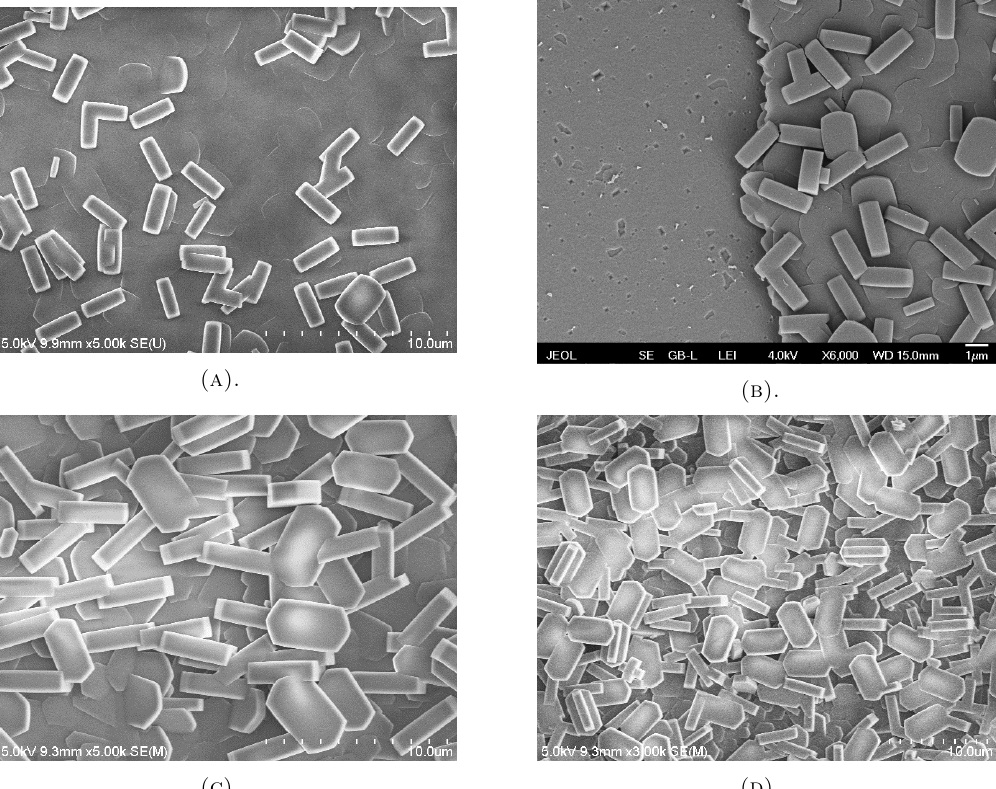
Figure 1. SEM image of SC-Si(100) (top) and SC-ss (bottom). Left: a centre of the films: left, right: a periphery of the films.